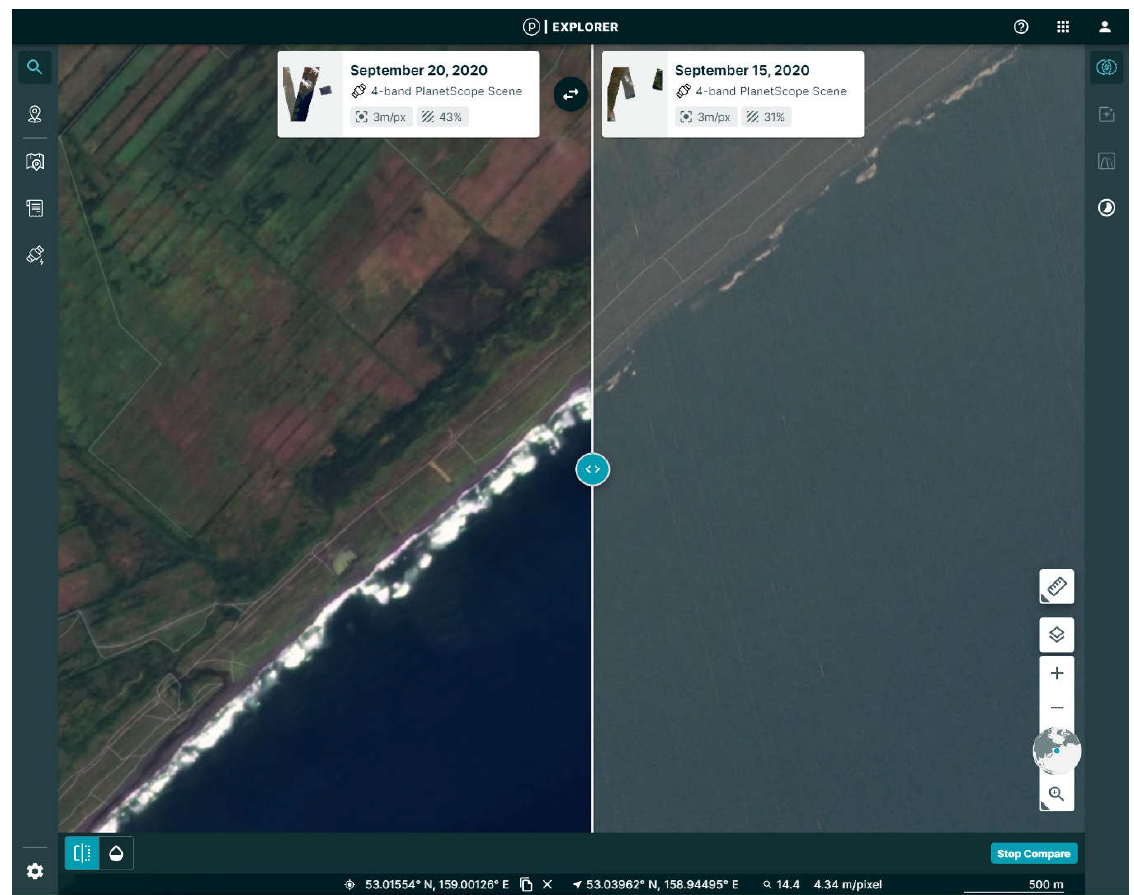
Figure 6. The width of the foam stripe on September 20 compared to the stripe width of a randomly selected image before the storm at the same characteristic near-surface wind speed. View of Khalaktyrsky beach on two SkySat-C satellite images docked along an arbitrarily chosen vertical line for September 20 ( left ) and September 15 ( right ).